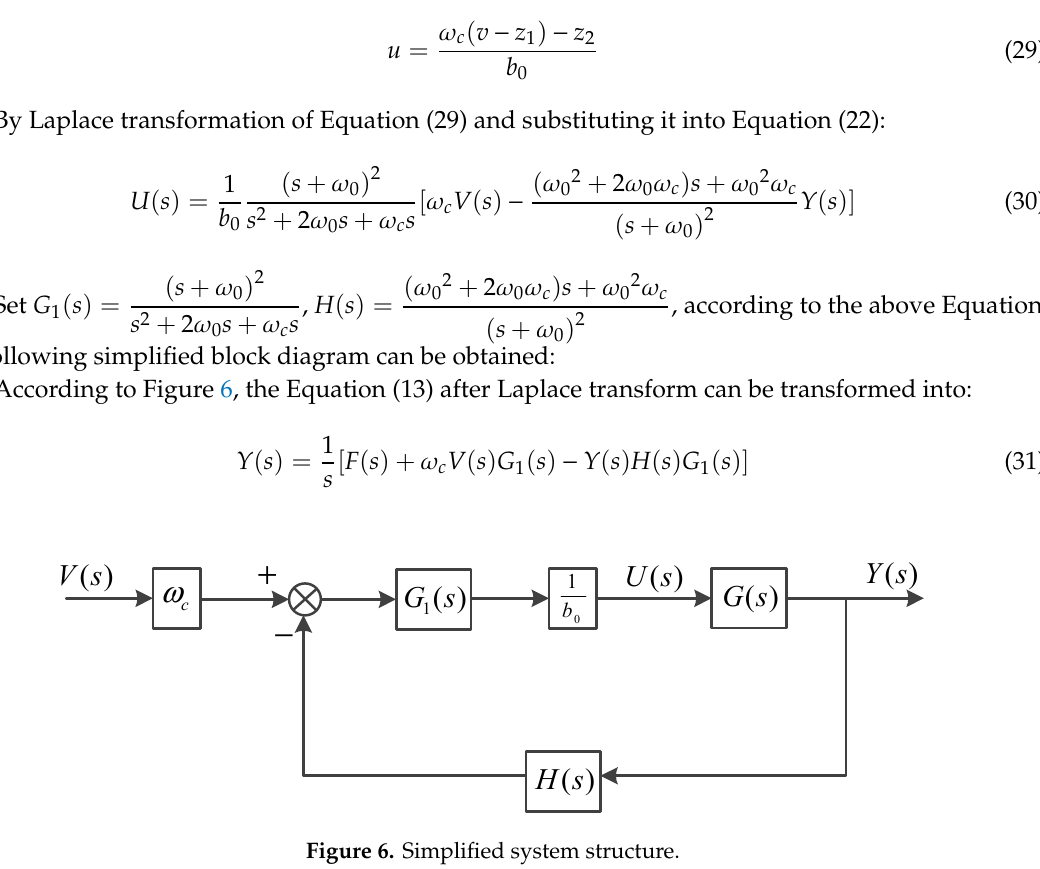
Figure 6. Simplified system structure.